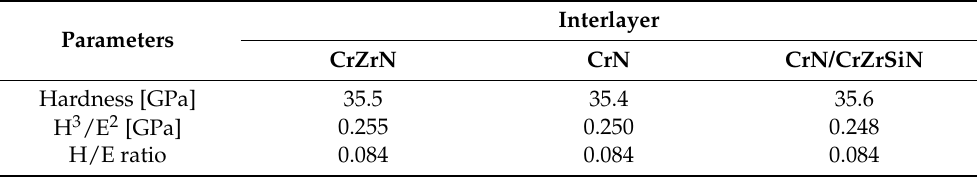
Figure 6. ( a ) Friction coefficient and ( b ) surface roughness values of the CrAlN coatings with three interlayers at room temperature and 500 °C. Table 3. Hardness, H 3 /E 2 parameter, and H/E ratio of the CrAlN coatings with three interlayer types after an annealing test at 500 ◦ C in air for 30